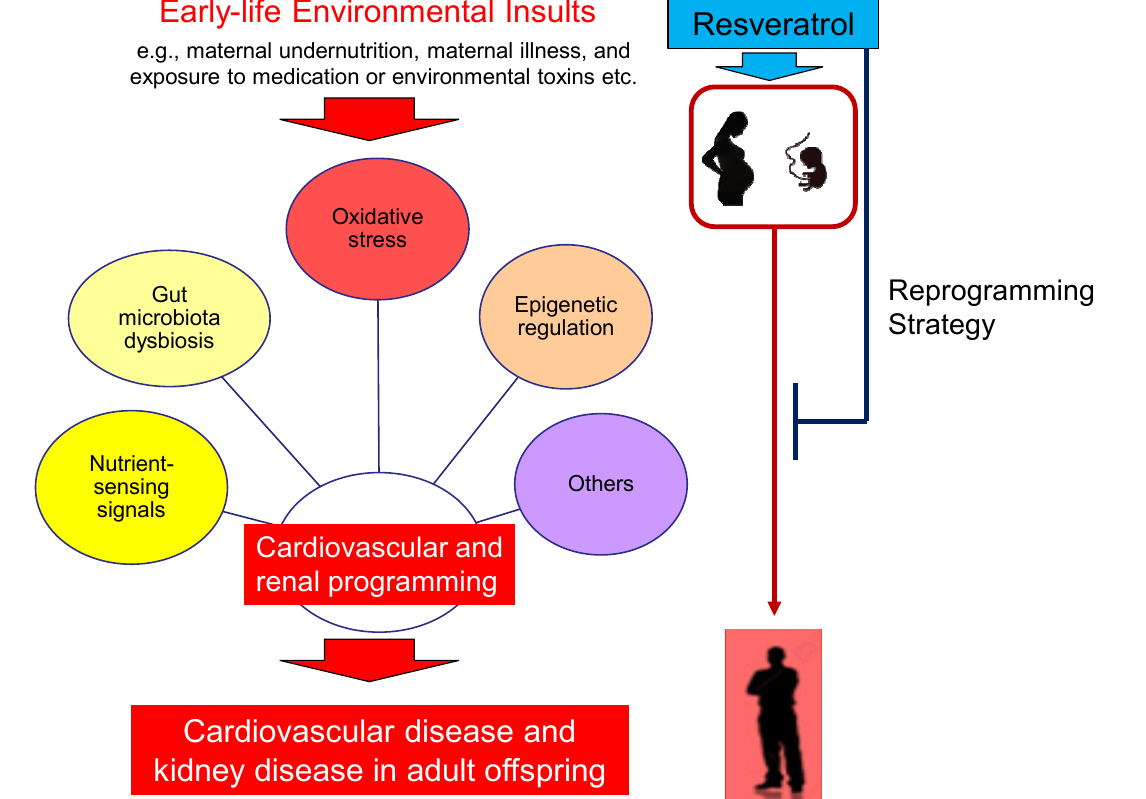
Figure 2. Schema outlining the cardiovascular and renal programming versus reprogramming strategy. Various early-life environmental insults can induce cardiovascular and renal programming, consequently leading to cardiovascular disease (CVD) and kidney disease in adulthood. Several common mechanisms have been proposed behind the pathogenesis of CVD and kidney disease of developmental origins, like oxidative stress, dysregulated nutrient-sensing signals, gut microbiota dysbiosis, and epigenetic regulation. Conversely, early resveratrol therapy can reverse or delay programmed processes to avoid the development of CVD and kidney disease via reprogramming. Table 1. Eligible animal studies reporting offspring outcomes related to CVD and kidney disease after resveratrol supple- mentation.